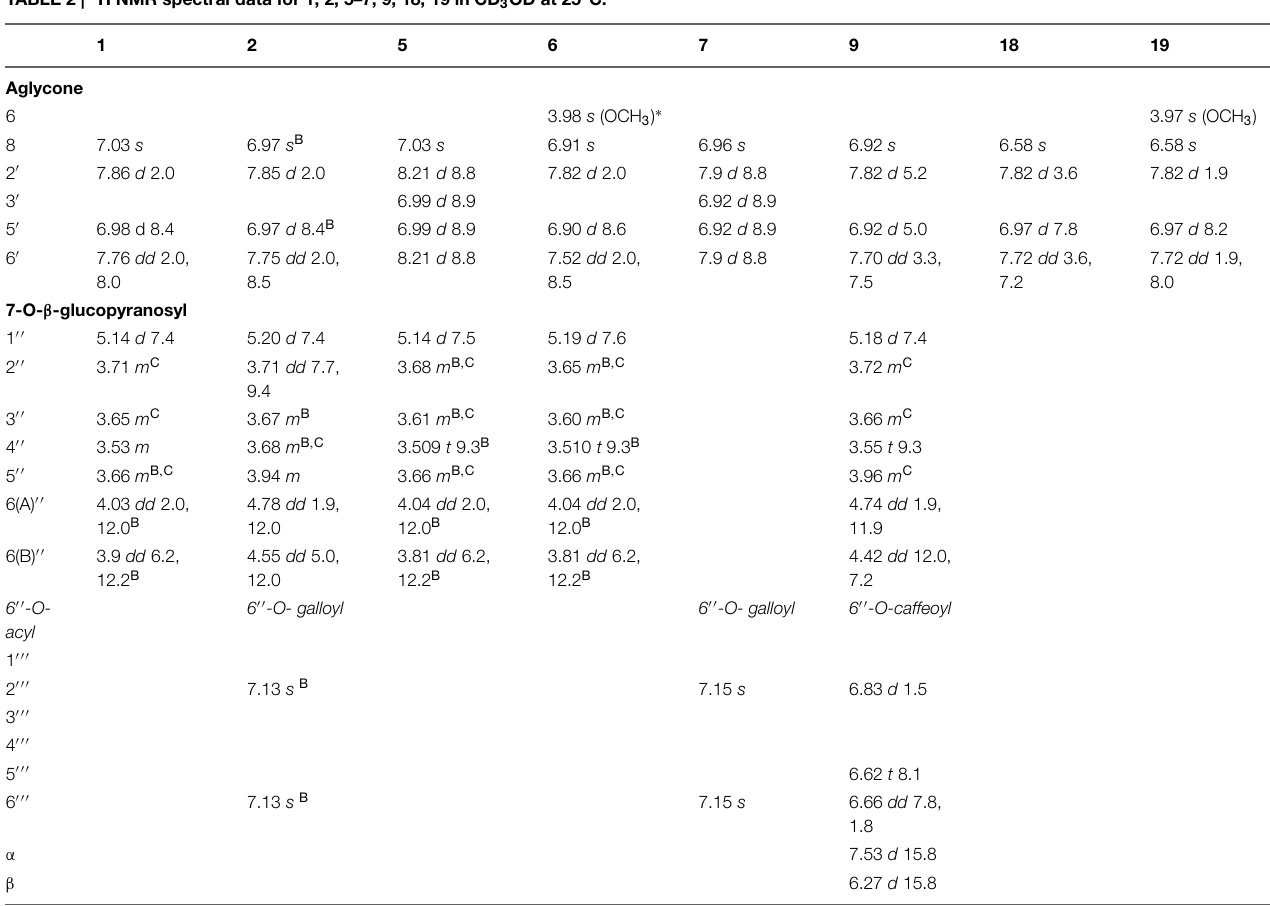
Compounds 3, 10–14 were in very low concentration. TABLE 2 | 1 H NMR spectral data for 1, 2, 5–7, 9, 18, 19 in CD 3 OD at 25 ◦